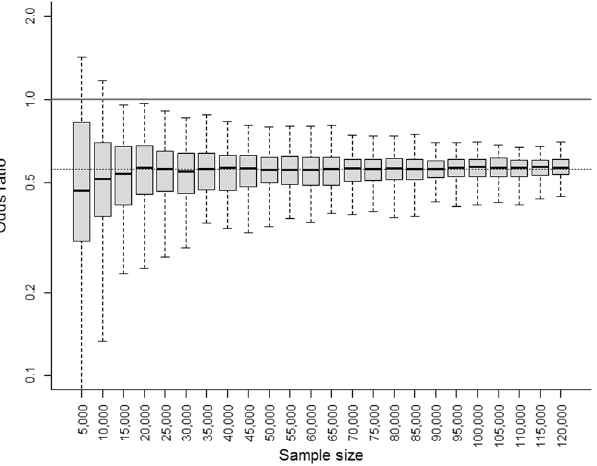
Figure 2. Sensitivity analysis for re-estimating the effect of rehabilitation on 30-day readmission in random subsamples of varying